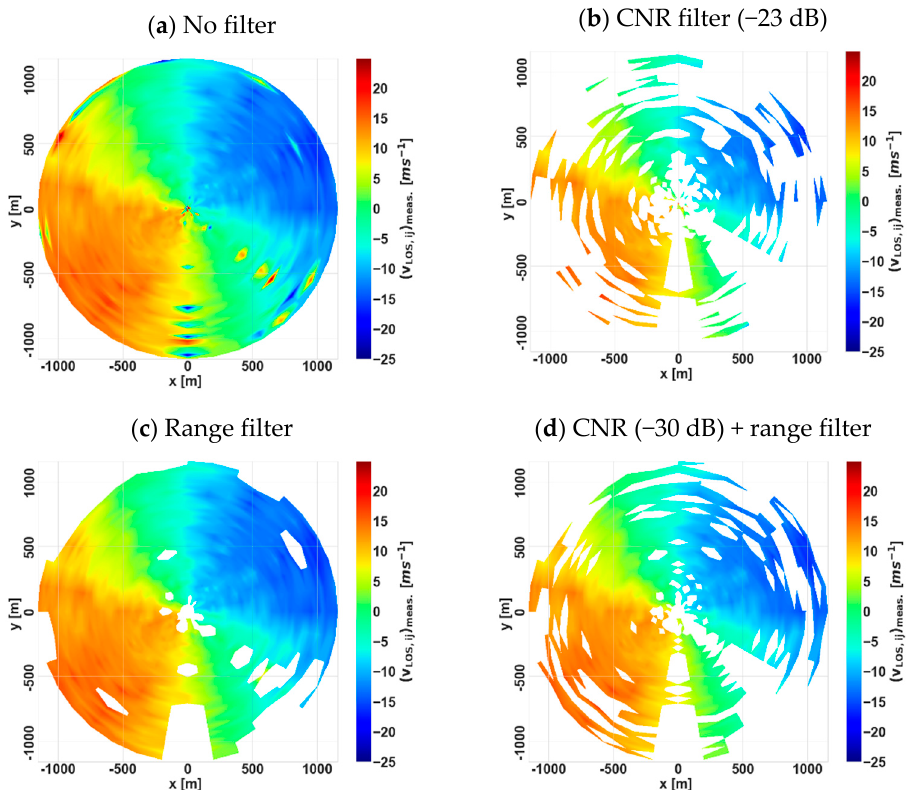
Figure A1 . Illustration of different filters for the processing of the radial wind speed measure- ments of the scanning lidar; for explanations see